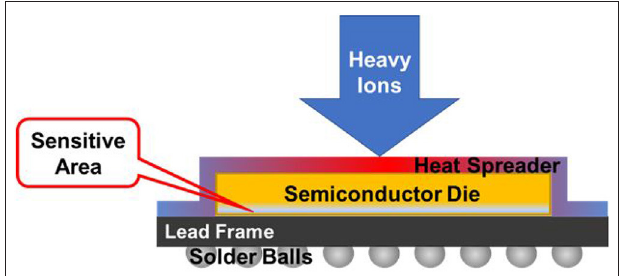
FIGURE 11 | Package of a modern SOC device.